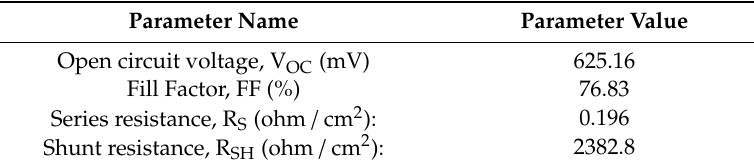
Figure 6. Experimental vs. Quokka 2 modeled J-V curve. Table 1. Experimental J-V fit parameters for the c-Si subcell.